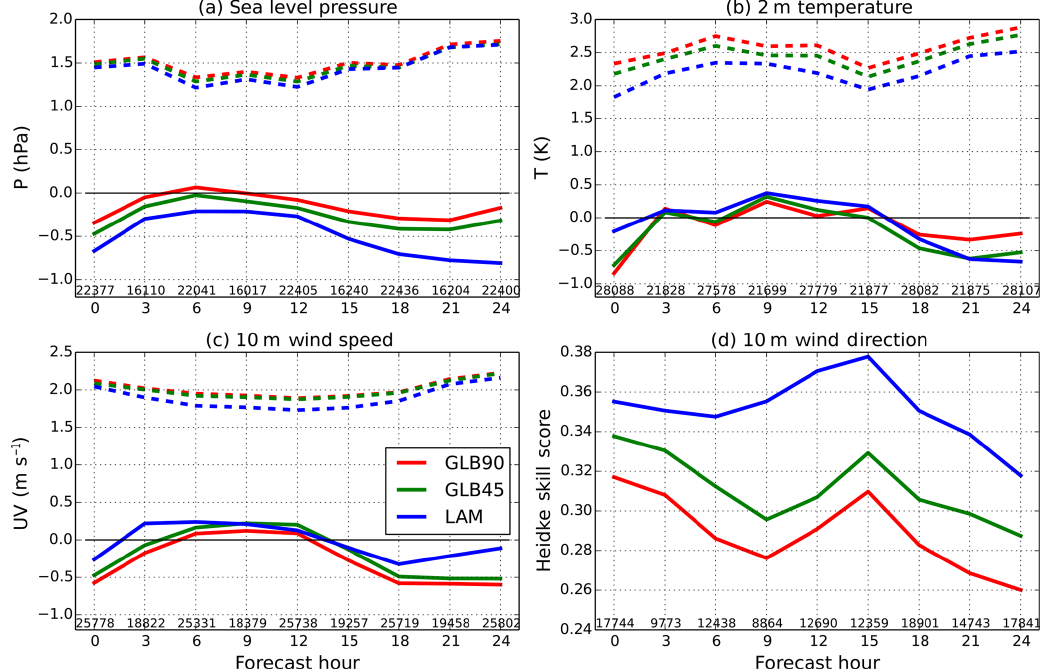
Figure 5. The bias (solid line) and standard error (dashed line) of (a) sea level pressure (hPa), (b) 2m temperature (K), (c) 10m wind speed (ms − 1 ) and (d) Heidke skill score of 10m wind direction from the GLB90 (red), GLB45 (green) and LAM (blue) experiments based on a comparison of forecasts against surface-based stations over North America for July 2015. The numbers at the bottom of each panel denote the number of observations used in the statistics at each forecast hour.